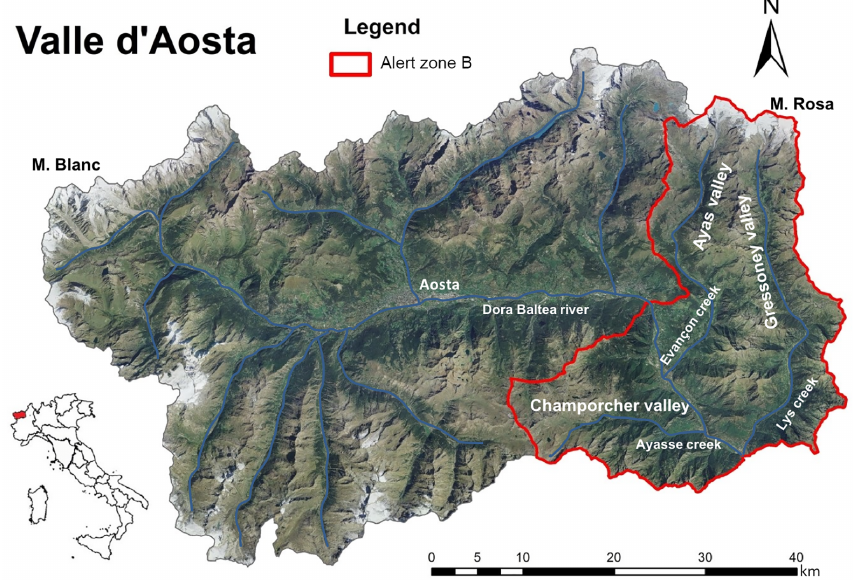
Figure 1. The Aosta Valley region in northwest Italy. The study area, alert zone B, is delineated in red.